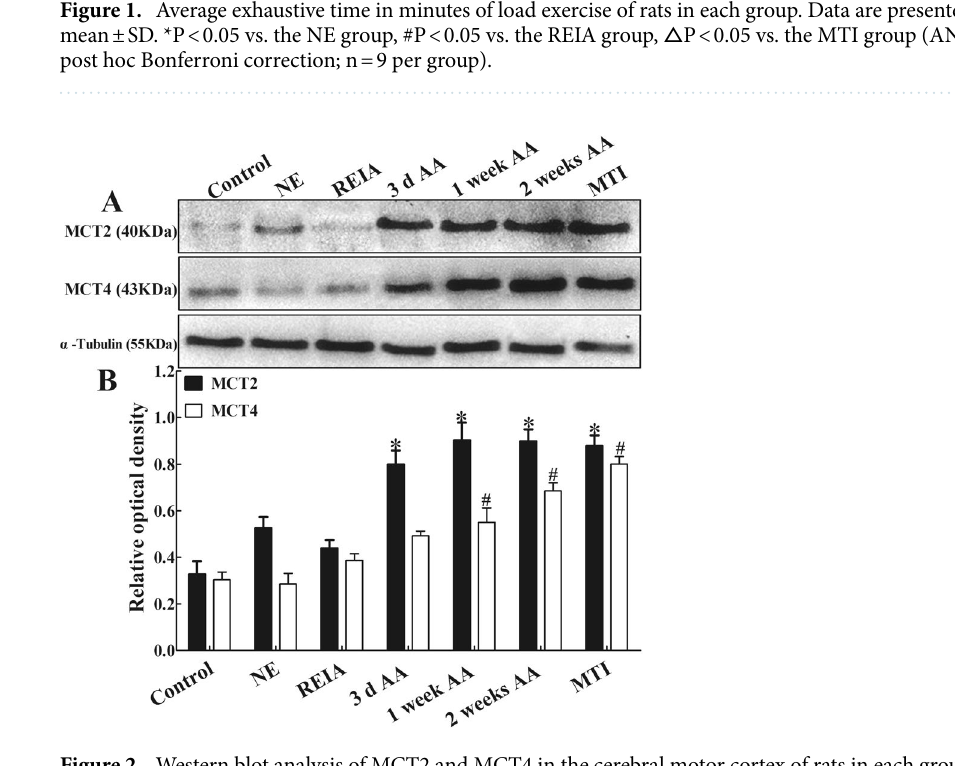
Figure 2. Western blot analysis of MCT2 and MCT4 in the cerebral motor cortex of rats in each group. ( A ) Representative cropped immunoblots showing a 40-kDa band corresponding to MCT2 protein and a 43-kDa band corresponding to MCT4 protein, with a-tubulin (55-kDa band) as a loading control. Original blots are presented in the Supplementary Figure original blots. ( B ) Results of the relative quantitative analysis. *P < 0.05 vs. the control group for MCT2; # P < 0.05 vs. the control group for MCT4 (ANOVA with post hoc Bonferroni correction; n = 3 per group). The original images of full-length blots with membrane edges visible can be found in the Supplementary Information